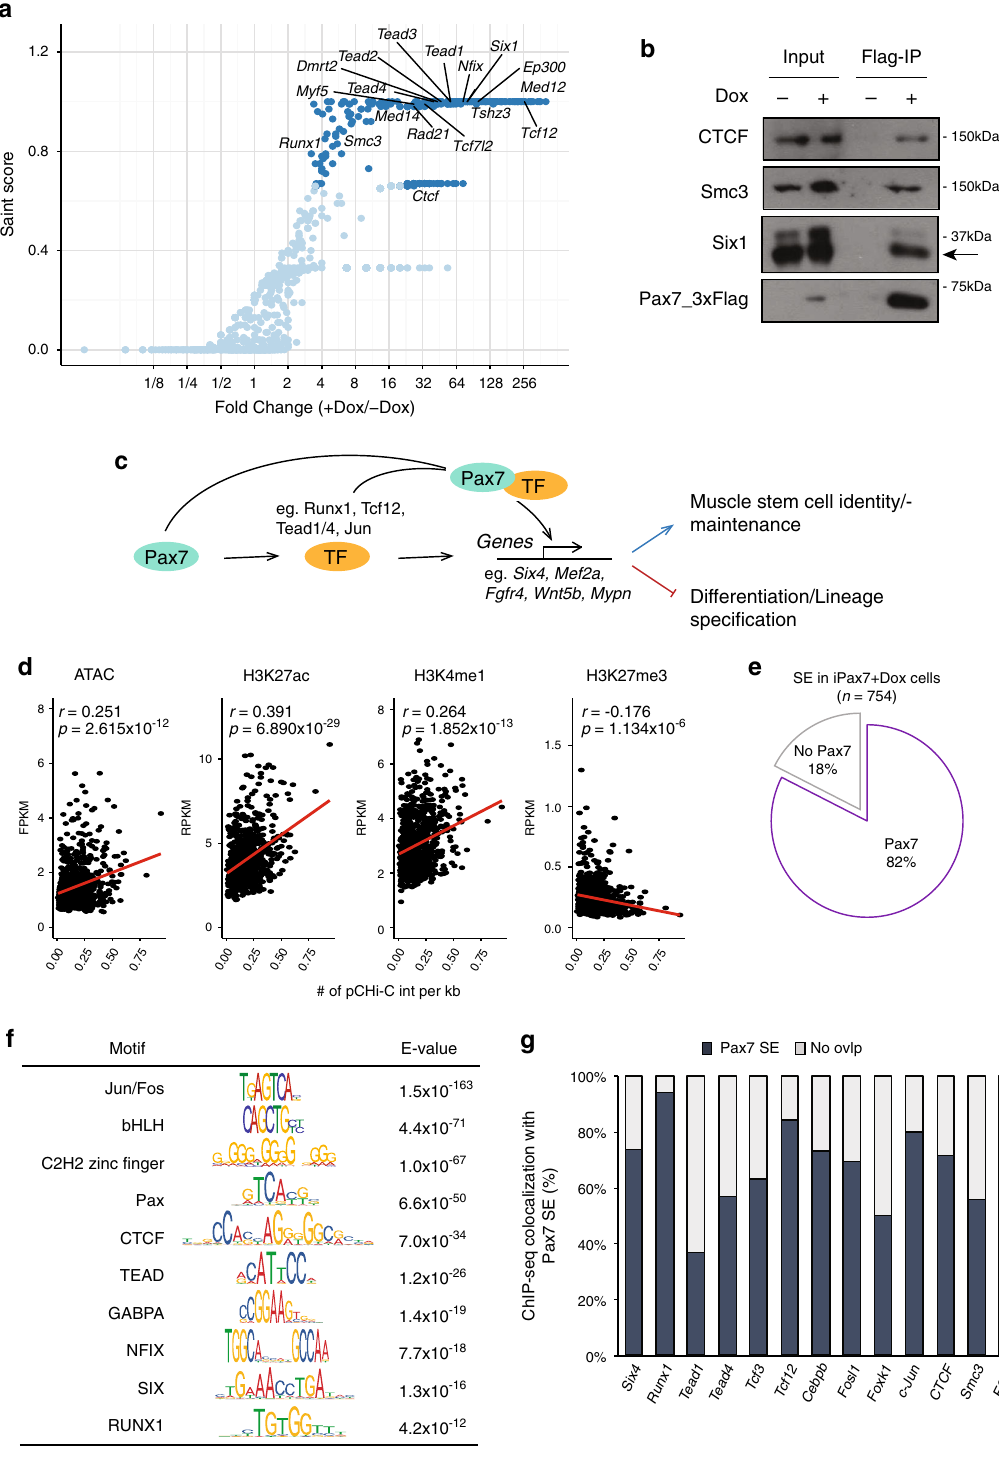
Fig. 5 Pax7 assembles feed-forward loops with its target TFs. a SAINT analysis revealing high-scoring Pax7-associated proteins detected by IP-MS. Proteins identi fi ed as high-con fi dence interactors of Flag-tagged Pax7 are marked in dark blue; n = 3 (biological replicates). b Immuno-blot con fi rming interactions between indicated proteins and Flag-tagged Pax7 in iPax7 cells. c Schematic representation of a feed-forward regulatory loop assembled by Pax7 and its target TFs. d Pairwise Pearson correlation between the number of high-con fi dence pCHi-C interactions per kb and signals for ATAC-seq and ChIP-seq for histone modi fi cations at SEs in iPax7 muscle progenitors. A linear regression line ( y ~ x ) is plotted in red; r , Pearson correlation coef fi cient; p values determined by two-tailed Student ’ s t -test. e Venn diagram indicates that most SEs identi fi ed in + Dox iPax7 cells that display high-con fi dence pCHi- C interactions contain Pax7-bound active enhancers. f Highly enriched TF binding motifs identi fi ed in SEs with pCHi-C interactions in + Dox iPax7 cells. The E -value is the p value derived from a one-tailed binomial test multiplied by the number of motifs in the input database. g Quanti fi cation of ChIP-seq peaks detected at Pax7 site-containing SEs. E2F4, control TF not detected as a Pax7